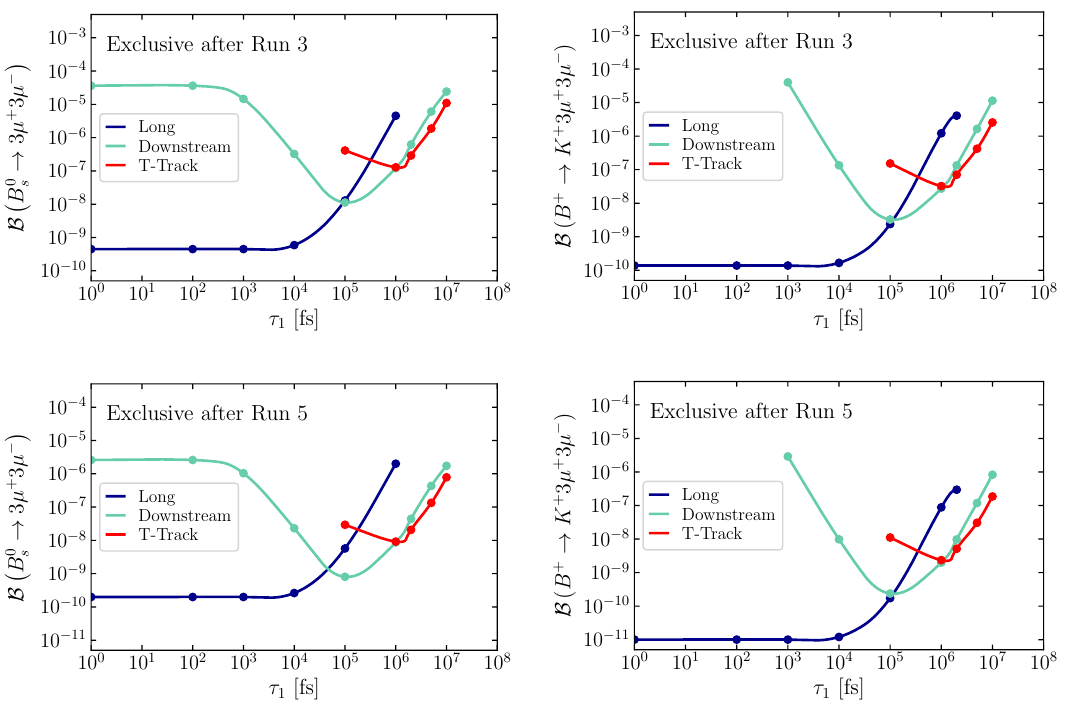
Figure 2 . The expected upper limits on the B 0 → 3 µ + 3 µ − and B + → K + 3 µ + 3 µ − branching s fractions that can be derived from the exclusive searches proposed in this work, for different lifetimes of the a 1 particle. In the upper (bottom) panels, the detector configuration after Run 3 (Run 5) is assumed. The benchmark masses were fixed to ( m 1 , m 2 ) = (1 . 0 , 2 . 5)